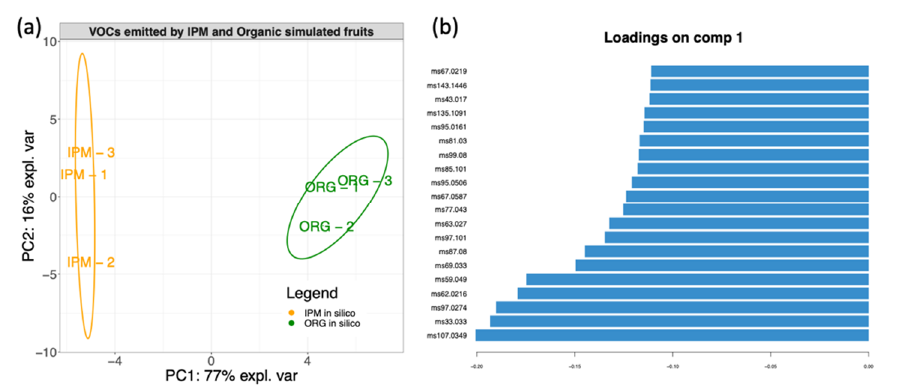
Figure 8. Characterization of volatile organic compound profiles, produced by assembling the emissions of single bacterial isolates from organic or IPM grown raspberries. Diagram shows ( a ) Principal Component (PC) 1 and 2 of principal component analysis (PCA) of the simulated fruits. Ellipses enclose confidence level = 95%. ( b ) loadings of the 20 m / z fragments showing highest correlation with PC1 in the PCA